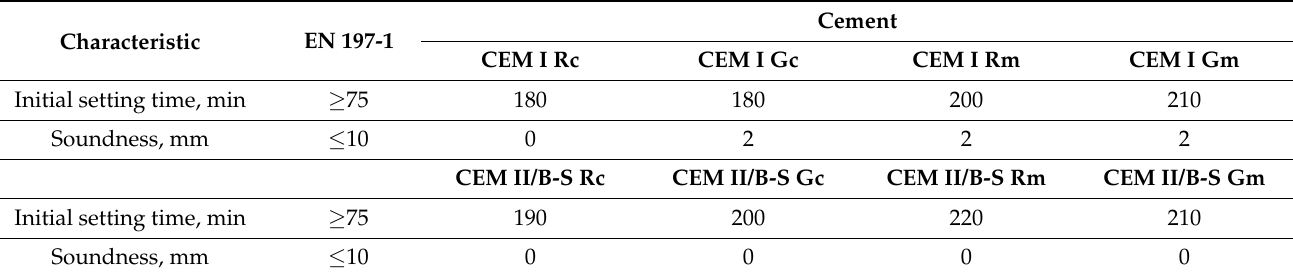
Table 6. Physical characteristics of obtained cements.